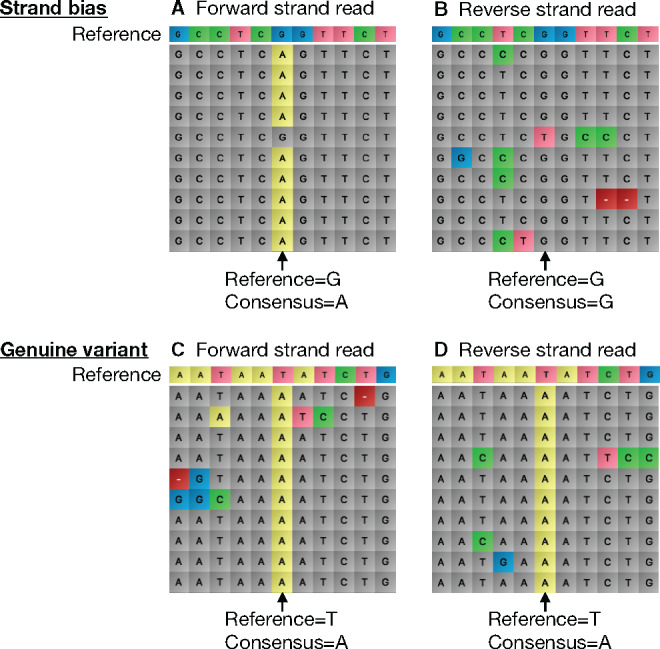
Examples of strand bias and a genuine SNV in nanopore data. Each row corresponds to a different read. Bases correctly aligned to the target sequence are shown in gray and potential mutations are highlighted in color (A = yellow, G = blue, T = pink, C = green, deletion = red). The consensus basecall is identified at the relevant position. Strand bias is shown by the inconsistent SNV basecalling between the (A) forward and (B) reverse strand reads from the same sample. Our statistical analysis of this alignment prevents erroneous SNV identification. In contrast, genuine SNVs are identified by an agreement between the (C) forward and (D) reverse strand read data.